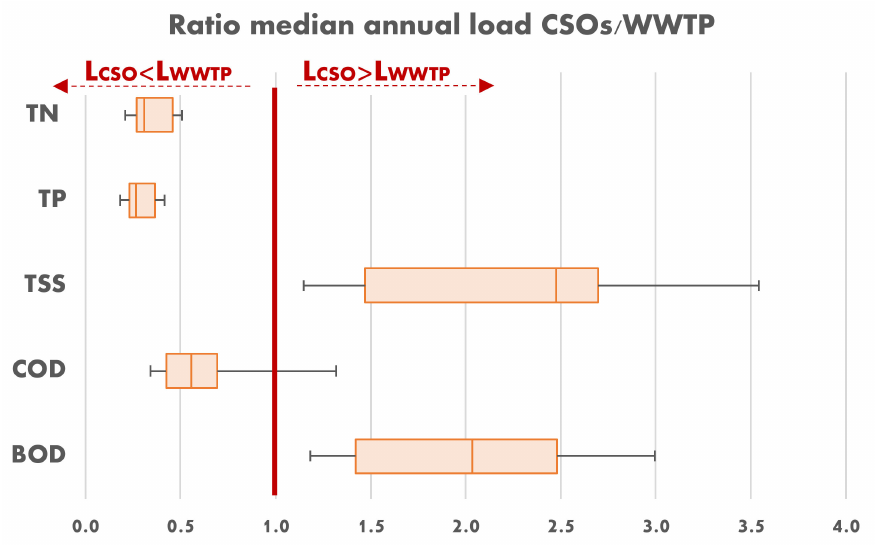
Figure 12. General yearly emitted load balance of CSOs vs. WWTP for 5 classic wastewater parame- ters (TN, TP, TSS, COD, BOD) based on Cockle calculations of 10